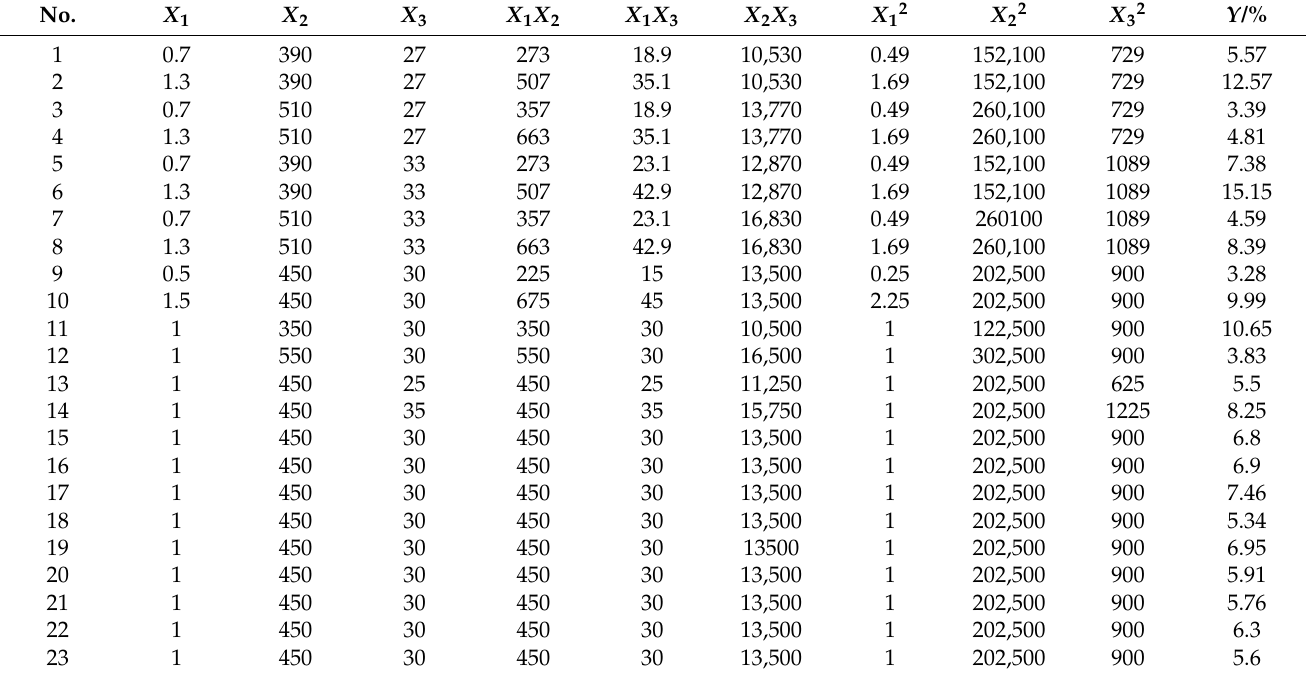
Table 4. Test scheme and response value results.